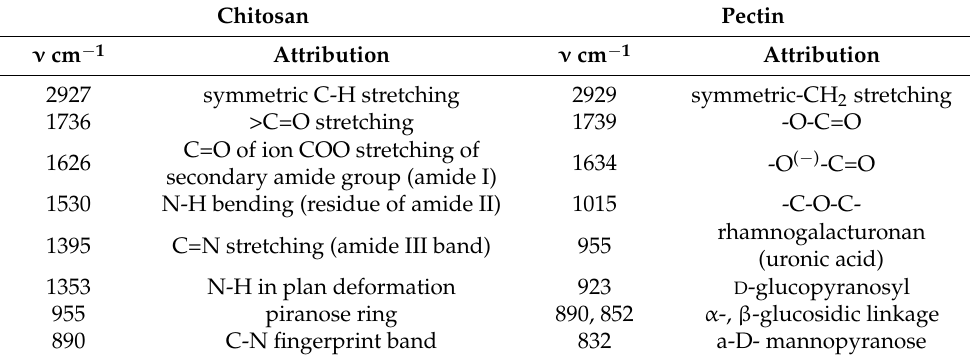
Table 3. Assignment of main IR absorption bands of Chitosan [14] and Pectin [34].